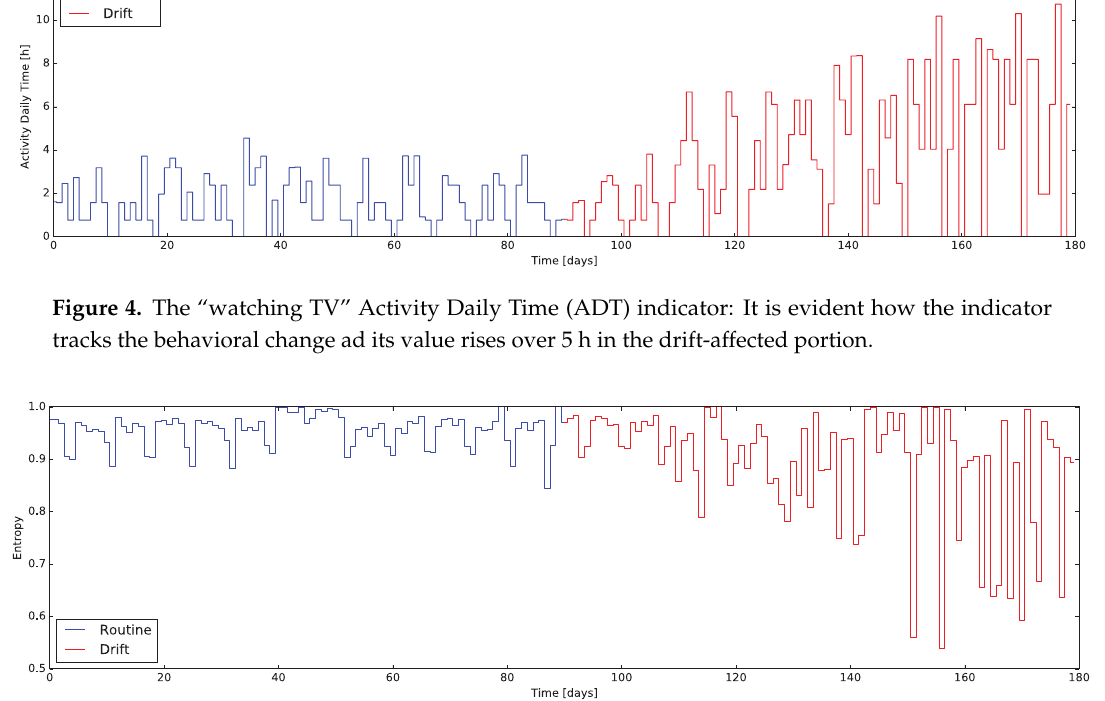
Figure 5. Bed Entropy Based (EB) indicator: the entropy represent different information with respect to the behavior of the indicator. In the picture it is already possible to identify consistent changes in the sleep pattern between days 30 and